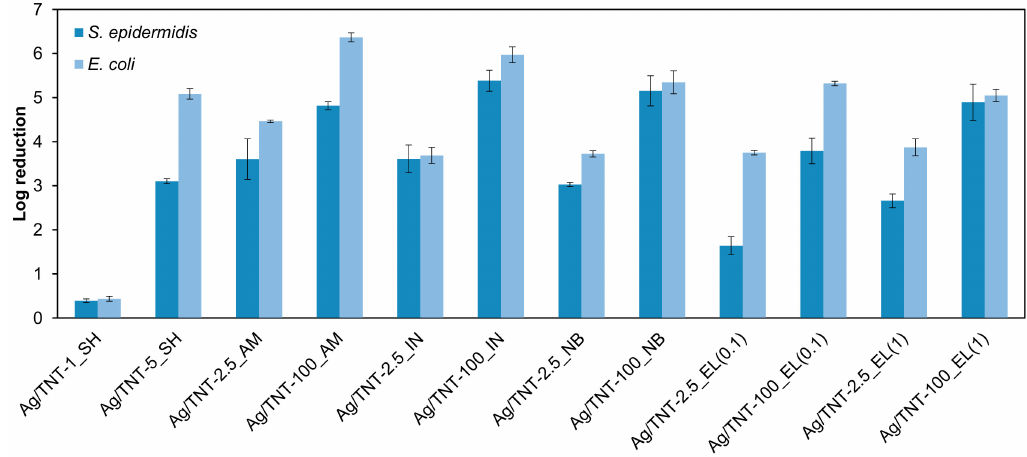
Figure 5. Antibacterial properties of Ag / TNTs towards E. coli and S. epidermidis